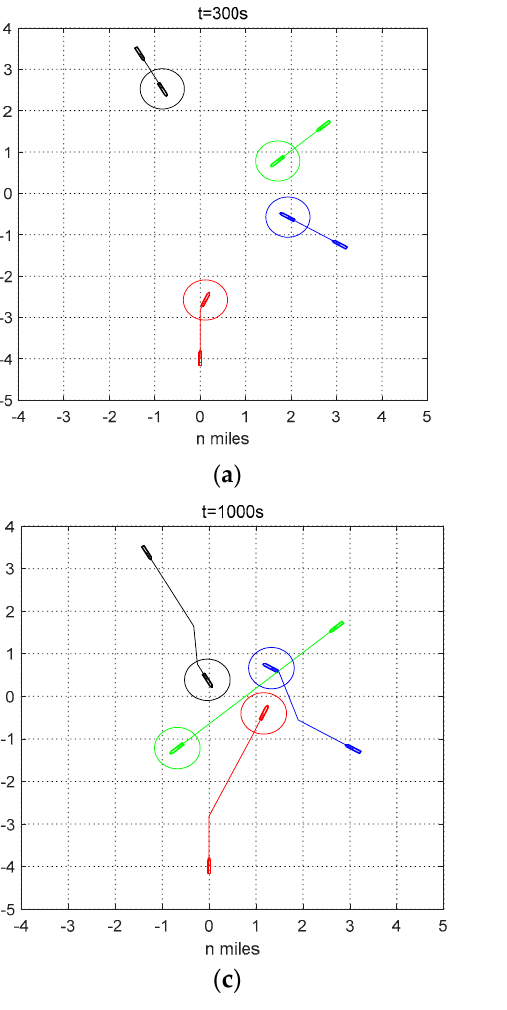
Figure 11. Ships' trajectories under scenario 4: ( a ) the positions and paths of ships at 300 s, ( b ) the positions and paths of ships at 700 s, ( c ) the positions and paths of ships at 1000 s and ( d ) the positions and paths of ships at 1500 s. Table 5. Actions taken by each ship in scenario